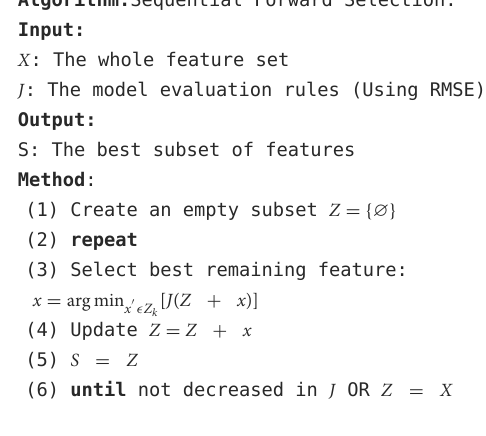
Algorithm 1. Pseudocode for the Sequential Forward Selection